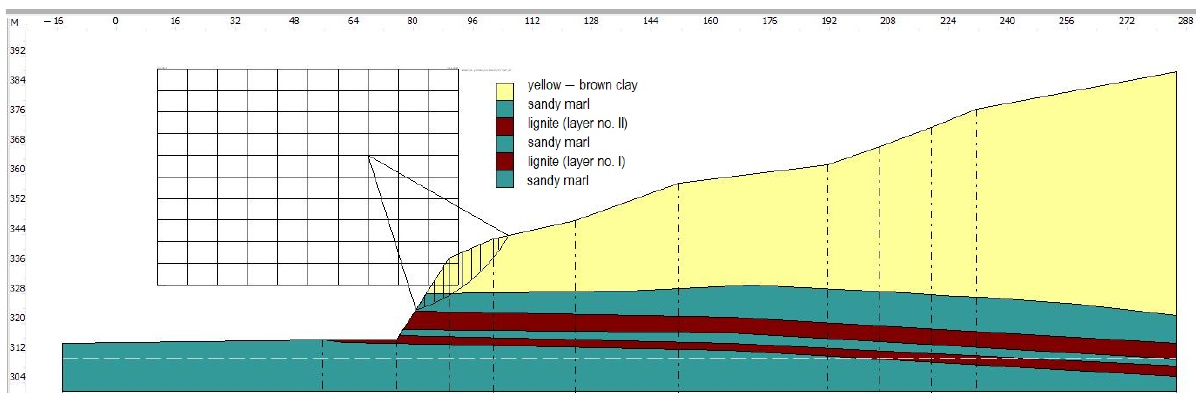
Figure 9. Section P2, IV quarter, F s1 = 0.80.